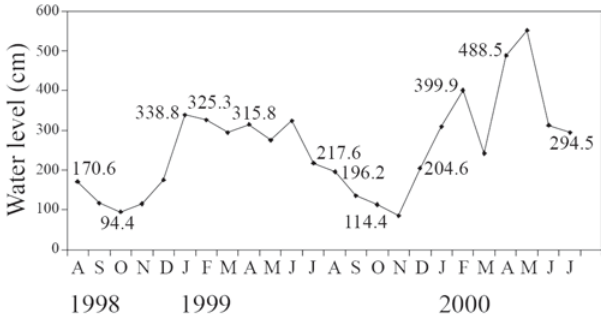
Fig. 2. Water level oscillation measured between August 1998 and July 2000 at the Hydrological station on the Comté River. The numbers indicate the mean water level during the month of